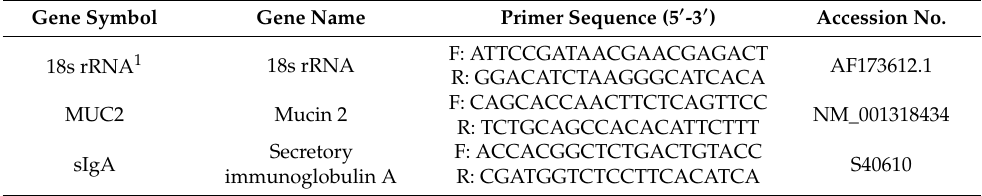
Table 2. Primer sequences used for RT-qPCR analysis (F: forward; R: reverse). Gene